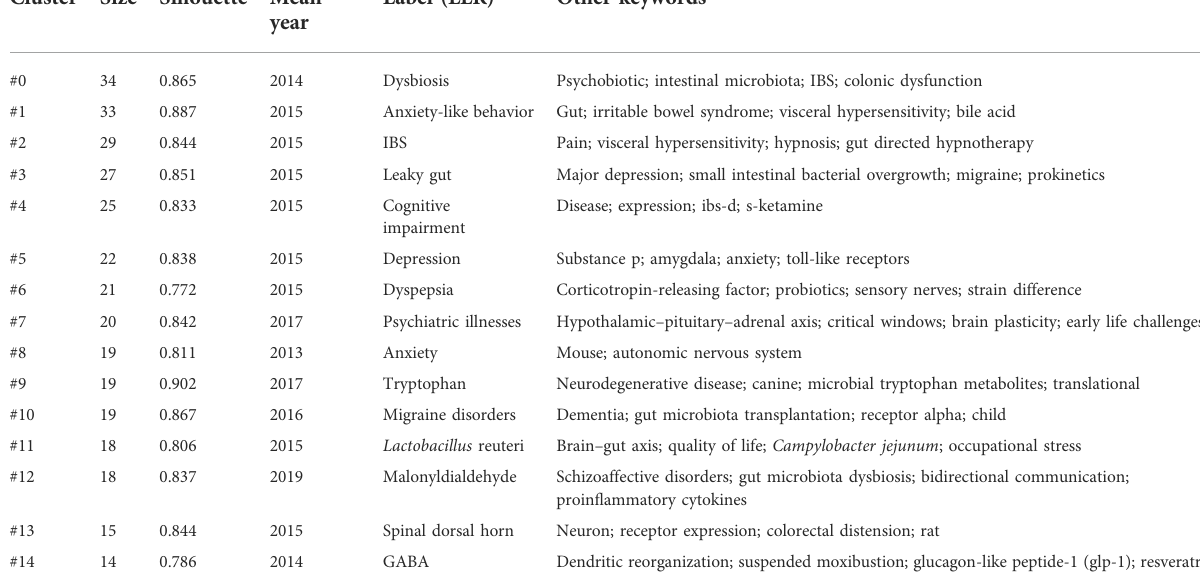
TABLE 4 Keyword cluster analysis (the silhouette value is over